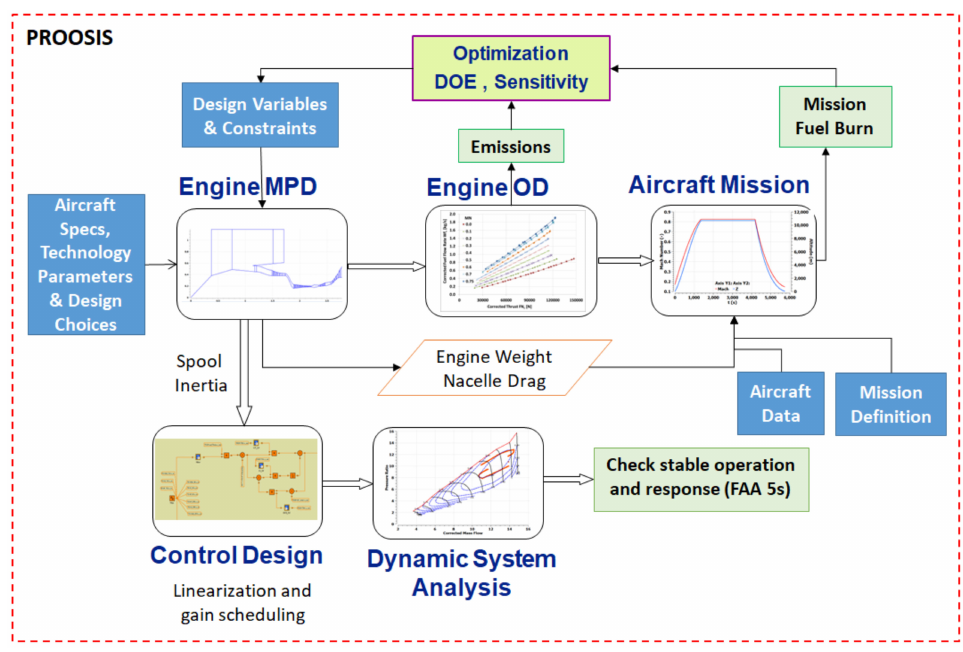
Figure 2. Simulation workflow for engine multi-disciplinary studies at the aircraft-mission